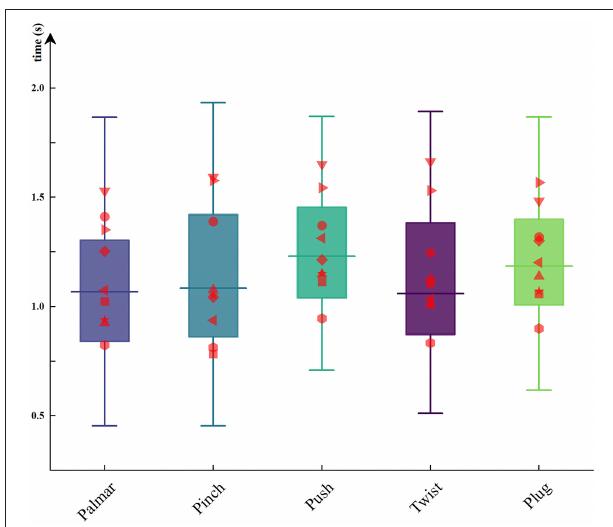
FIGURE 6 | The duration of each hand movement for all subjects. The red dots on the boxplots are subject-specific average